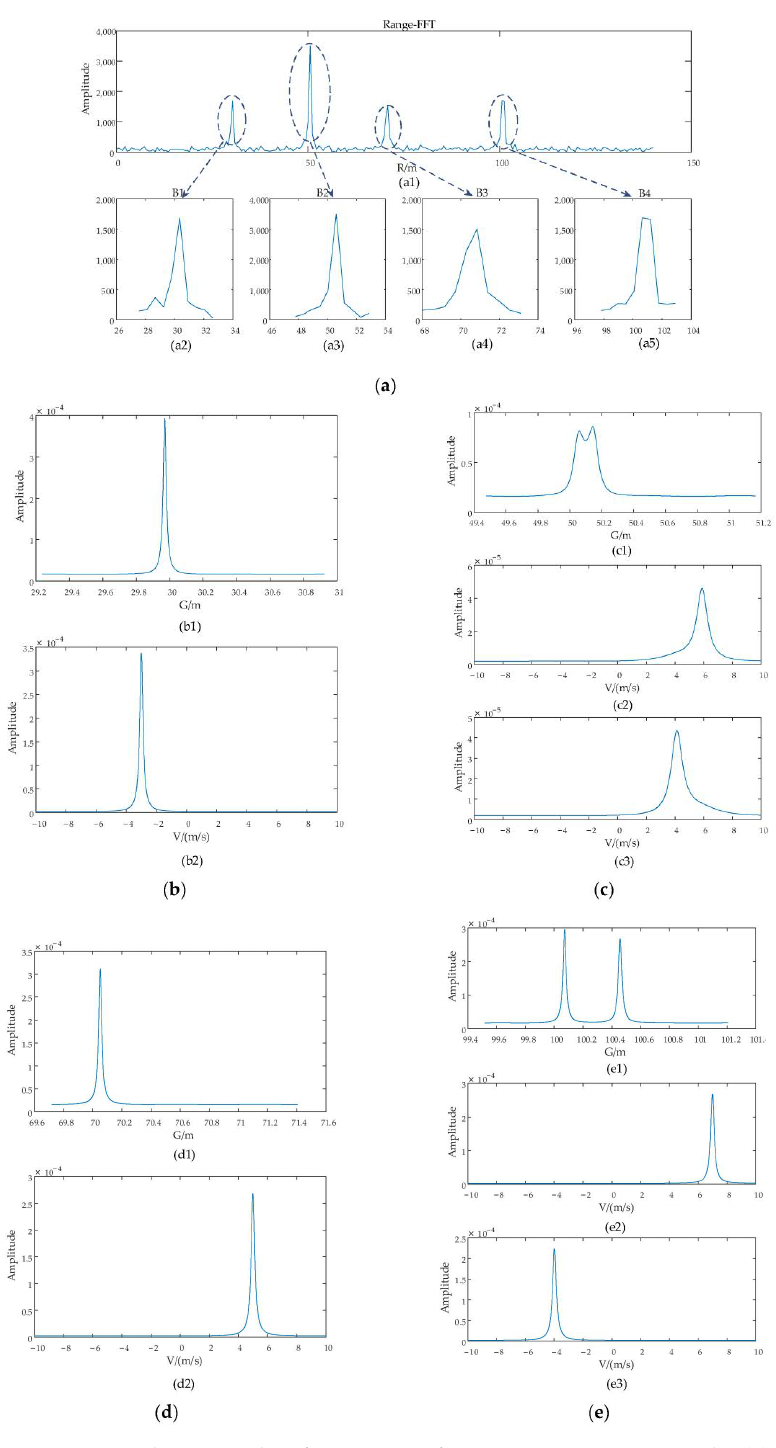
Figure 7. Simulation results of experiment for six targets at SNR = 10 dB. ( a ) is the targets-located blocks selection for range estimation. ( b ) is the G and V estimation process of B1. ( c ) is the G and V estimation process of B2. ( d ) is the G and V estimation process of B3. ( e ) are the G and V estimation process of